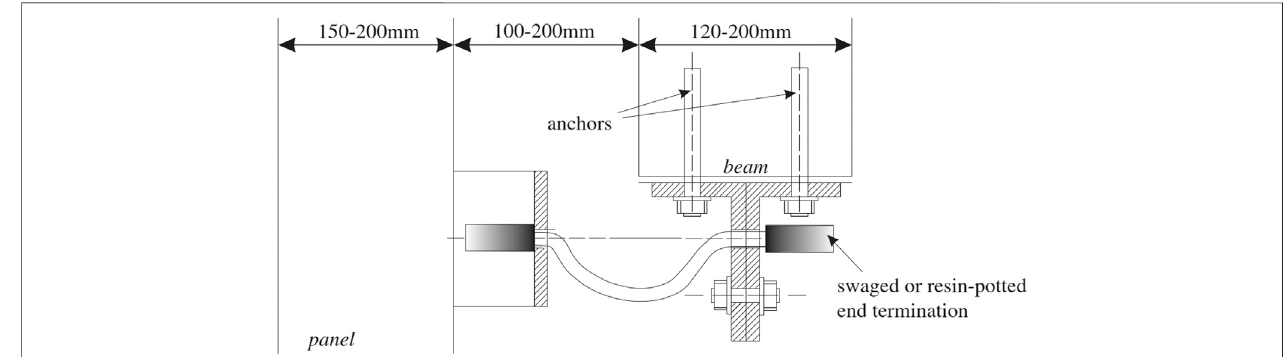
FIGURE12| Aschemeofarestrainer systemasastrengtheningsolutionfor theprotectionofcladding panelsuponthefailureoftheprimary cladding-to-structure connections [adapted from Zoubek et al. (2016b)].